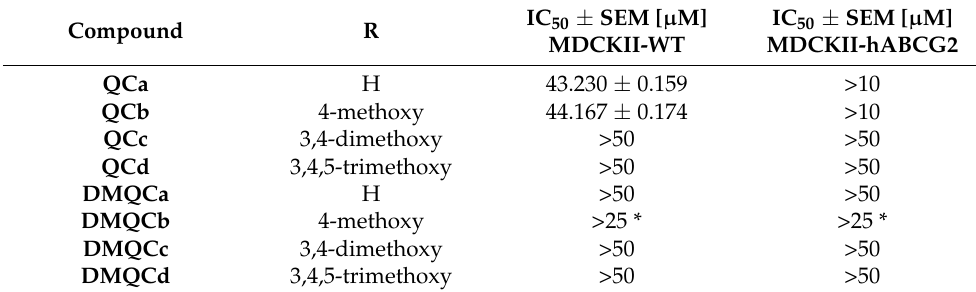
Table 1. Cytotoxicity of compounds QCa-d and DMQCa-d determined by WST-1 cell prolifera- tion assay using MDCKII wild-type (MDCKII-WT) and human ABCG2-transfected MDCKII cells (MDCKII-hABCG2). Data given as mean ± SEM of three independent experiments (N =